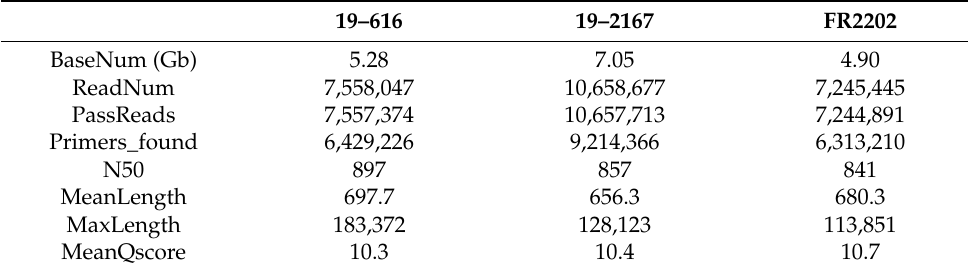
Table 1. Sequencing data and assembly results.